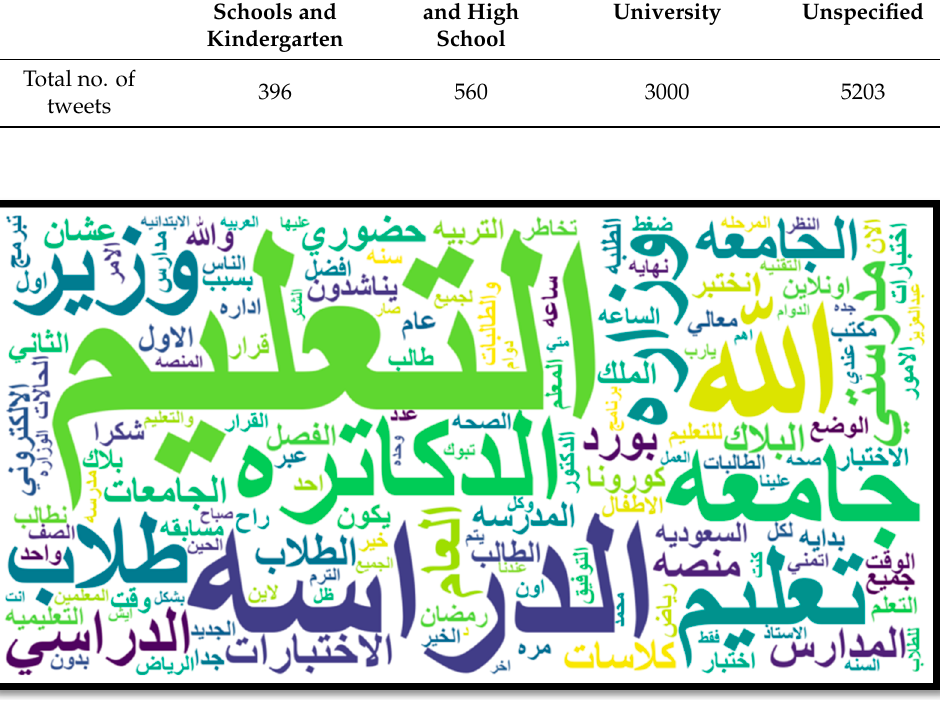
Figure 5. Word Cloud of common words in the application dataset. Table 7. Number of tweets in each educational stage for the second dataset (application dataset).